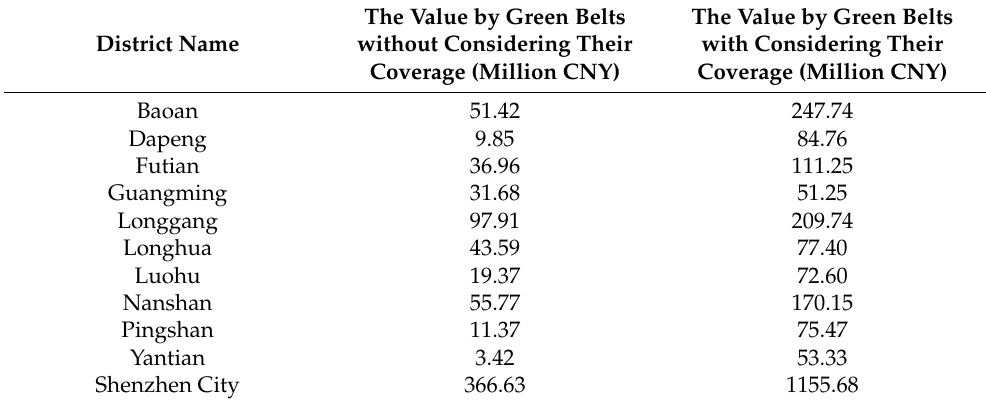
Table 3. Comparison of product value calculated by the two methods for the whole city and each